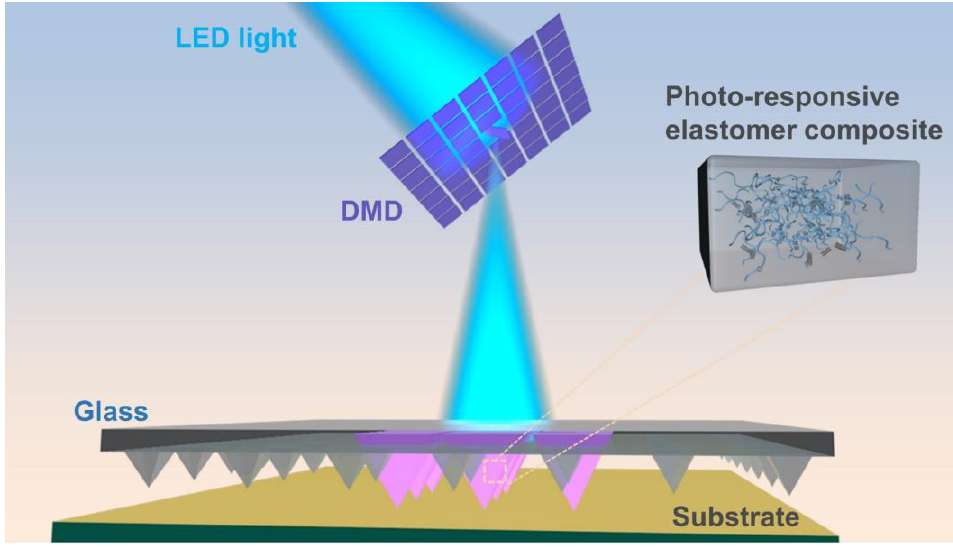
Figure 1. Scheme illustrating localized photoactuation for molecular printing. Digital micromirrors are used to direct light to selected pens for the nanolithography. The inset highlights the uniformly distributed functionalized short CNTs in PDMS.